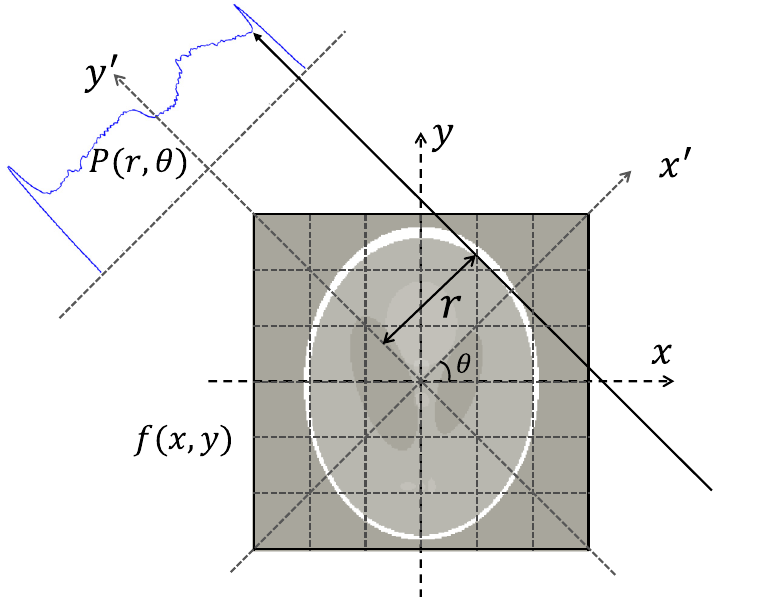
Fig 1. Parallel beam geometry. A one-dimensional detector-bin measures an integral of attenuation along the line at angle θ and distance r to the isocenter.